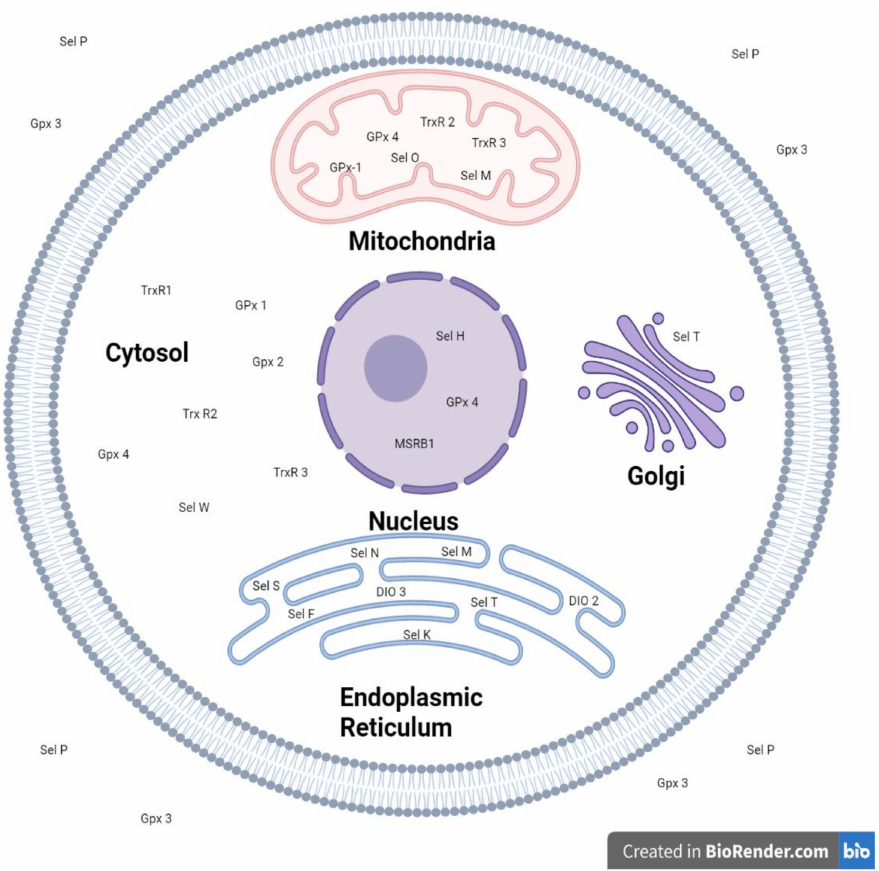
Figure 1. Cellular localisation of selenoproteins in a typical mononuclear eukaryotic cell. GPx1: Glutathione Peroxidase 1; GPx2: Glutathione Peroxidase 2; GPx3: Glutathione Peroxidase 3; GPx4: Glutathione Peroxidase 4; TrxR1: Thioredoxin Re-ductase 1; TrxR2: Thioredoxin Re-ductase 2; TrxR3: Thioredoxin Re-ductase 3; DIO2: Iodothyronine de-iodinase 2; DIO3: Iodothyronine de-iodinase 3; SelF: Selenoprotein F; SelN: Selenoprotein N; SelK: Selenoprotein K; SelM: Selenoprotein M; SelO: Selenoprotein O; SelP: Selenoprotein P; SelT: Selenoprotein T; SelW: Selenoprotein W; SelH: Seleno- protein H; MSRB1: Methionine sulfox-ide reductase